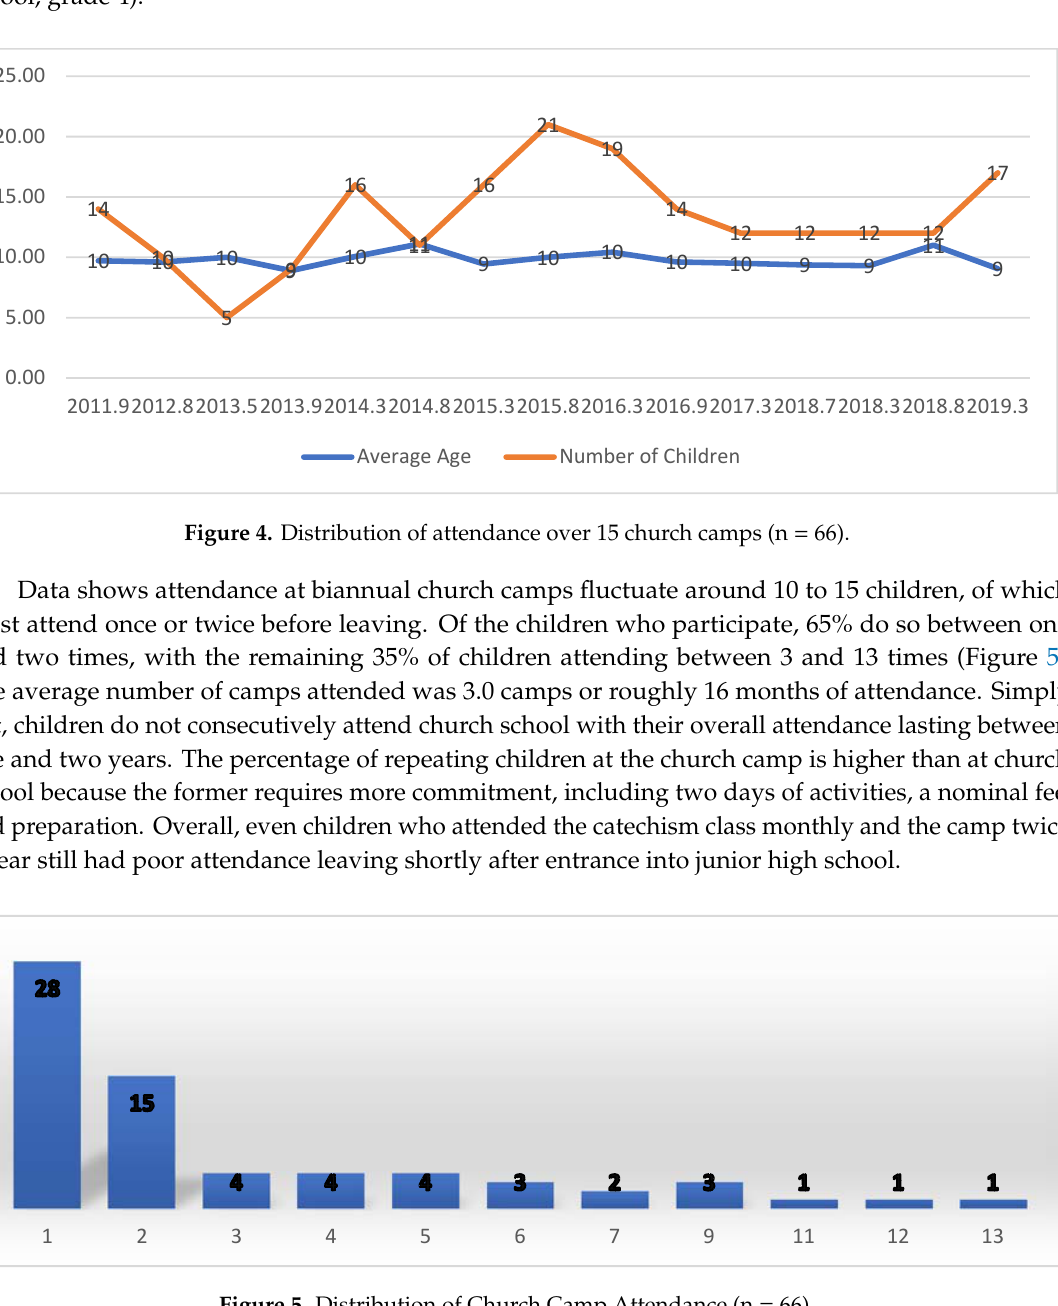
Figure 3. Distribution of church school attendance April 2017 to December 2018 (n = 102).